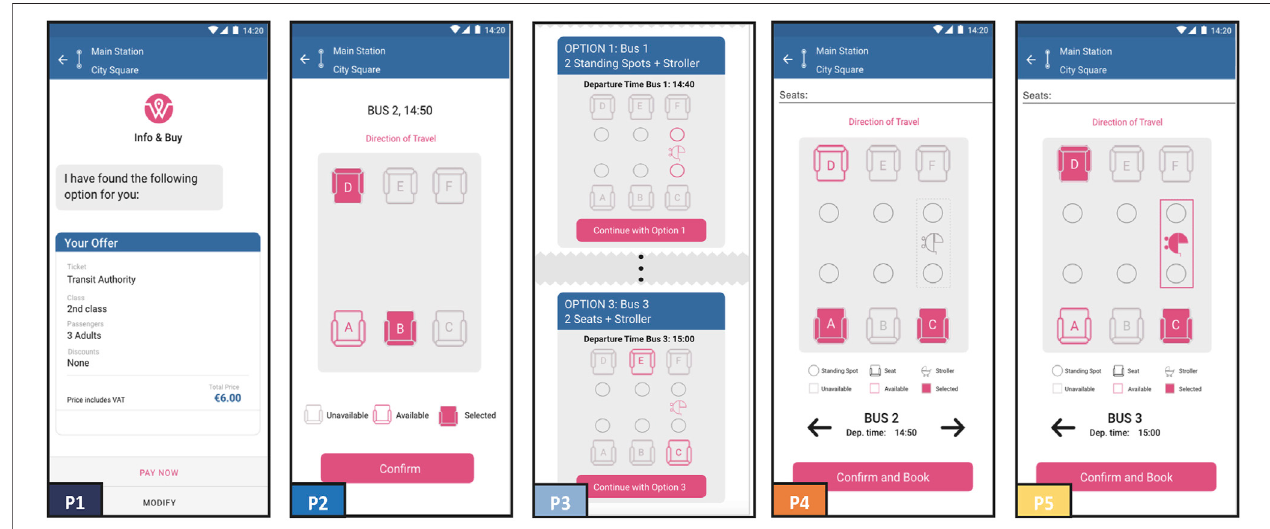
FIGURE 6 | Study 2: The interaction fl ow for all fi ve booking prototypes.